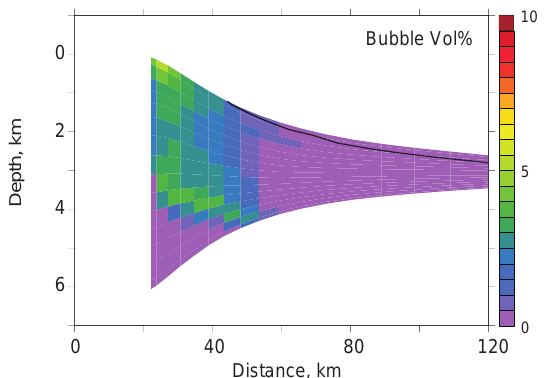
Fig. 12. Dissolved inorganic carbon (DIC) concentrations in molm − 3 , for the Base scenario with various other scenarios in the Supplement file dic.pdf. Solid black line is the stability boundary. Plotted with various other scenarios in Fig. 12 (Sup- plement). Animations can be seen at http://geosci.uchicago.edu/ ∼ archer/spongebob